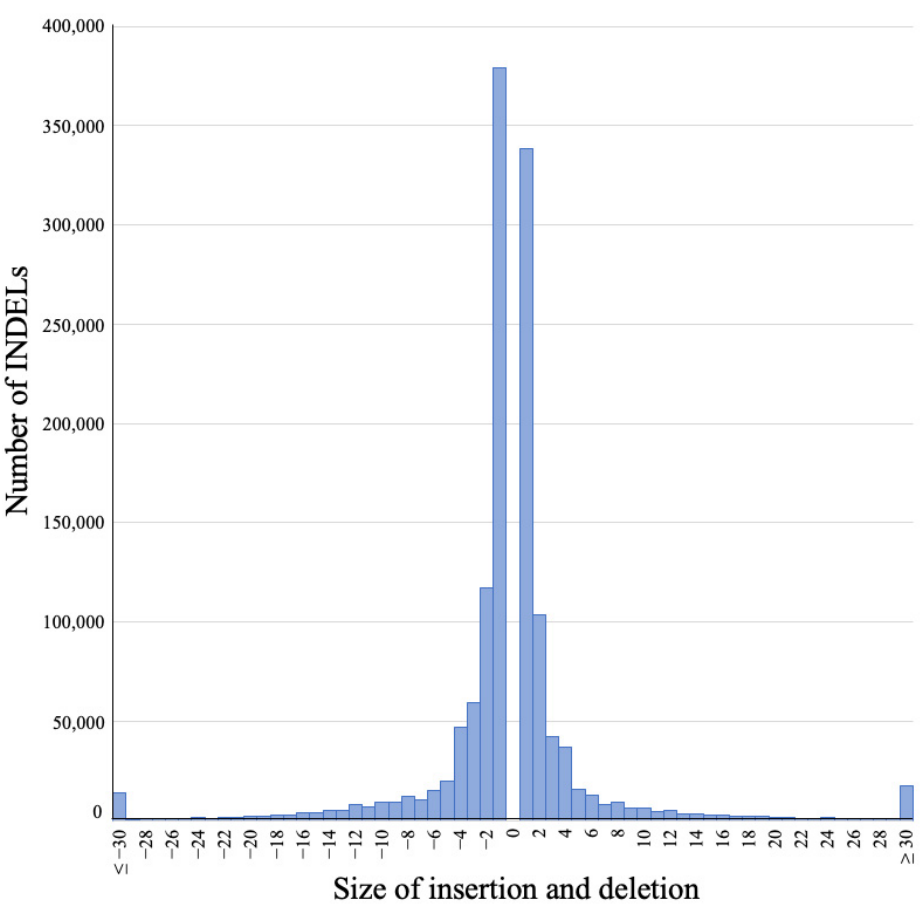
Figure 2. Distribution of insertion and deletion (INDEL) size detected in 101 Thoroughbred horses. The size of INDELs was calculated as Alt allele length–Ref allele length.